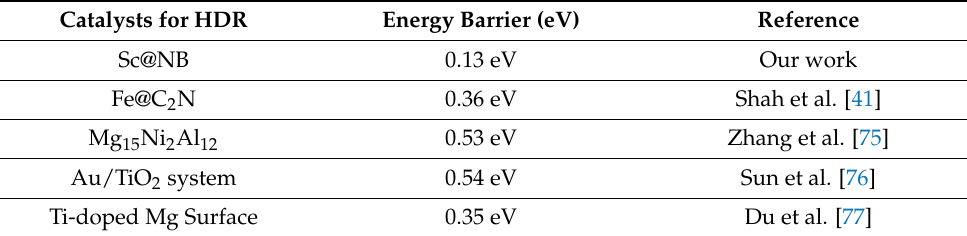
Table 4. Comparison of hydrogen dissociation barrier over Sc@NB catalyst with already reported barriers over various surfaces.